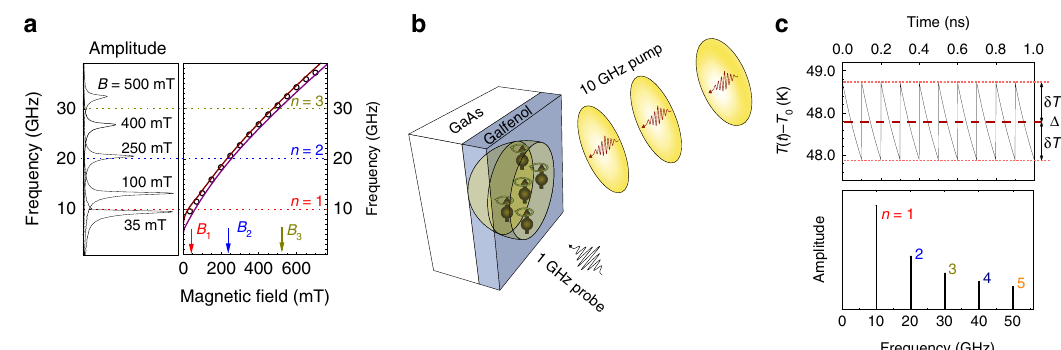
Fig. 1 Magnon resonances and temperature modulation. a Fast Fourier transform spectra showing the fundamental magnon mode for several values of magnetic fi eld, B (left panel) and the fi eld dependence of its frequency, f (right panel) for the 5-nm-thick Fe 0.81 Ga 0.19 energy-harvesting layer. Symbols show f ( B ) obtained by fast Fourier transformation of Kerr rotation signals measured in a single pulse pump – probe experiment. Solid lines are calculated dependences for Δ T = 0 K (upper curve) and Δ T = 200 K (lower curve). The dashed horizontal lines show the frequencies of the harmonics in the temperature modulation spectrum induced by the 10 GHz optical excitation. The vertical arrows indicate the expected resonances for the fundamental magnon mode at these harmonics. b Scheme of the experiment. c Calculated temporal evolution of the Fe 0.81 Ga 0.19 lattice temperature induced by the 10 GHz optical excitation of the Fe 0.81 Ga 0.19 /GaAs heterostructure at the pump excitation power W = 95 mW (upper panel) and its Fourier spectrum (lower